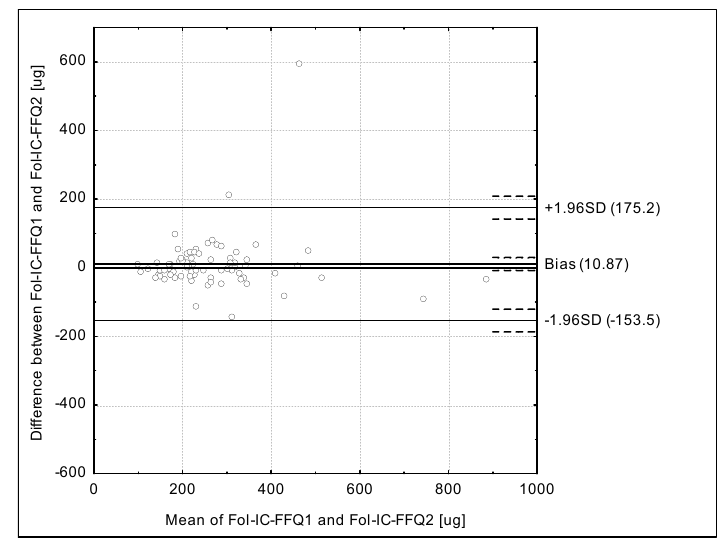
Figure 3. Bland ‐ Altman plot comparing Fol ‐ IC ‐ FFQ1 with Fol ‐ IC ‐ FFQ2 folate daily intake in the Figure 3. Bland-Altman plot comparing Fol-IC-FFQ1 with Fol-IC-FFQ2 folate daily intake in assessment of reproducibility (Bland–Altman index of 2.7%). Fol ‐ IC ‐ FFQ1: food frequency the assessment of reproducibility (Bland–Altman index of 2.7%). Fol-IC-FFQ1: food frequency questionnaire filled out directly after conducting 3-day dietary record; Fol-IC-FFQ2: food frequency